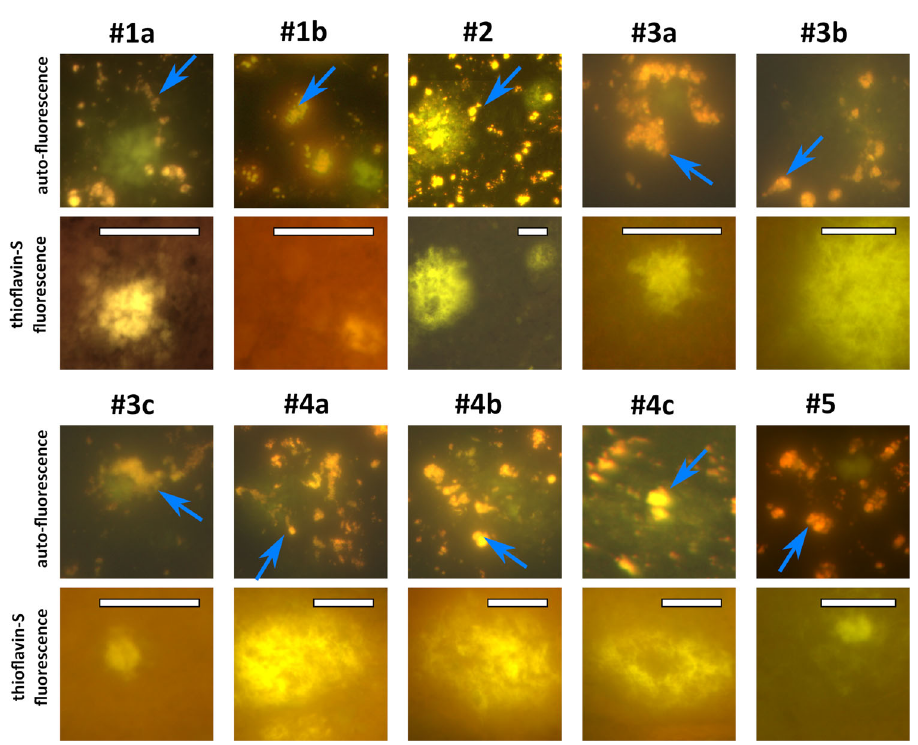
Fig. 3 Side-by-side comparison of plaque locations (as indicated by the yellow dashed boxes in Fig. 2 for cases #1a, #1b, and 2) of auto- fl uorescence images and the same location after staining with thio fl avin-S. The blue arrows point to lipofuscin deposits, which are not visible in the thio fl avin-S stained images since the fl uorescence of thio fl avin-S is stronger. Scale bars: 40 µ